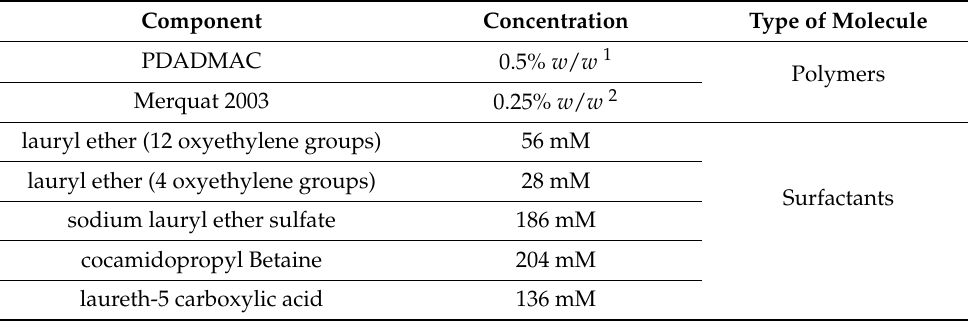
Table 2. Composition of the technical model’s formulation designed in this study. Component